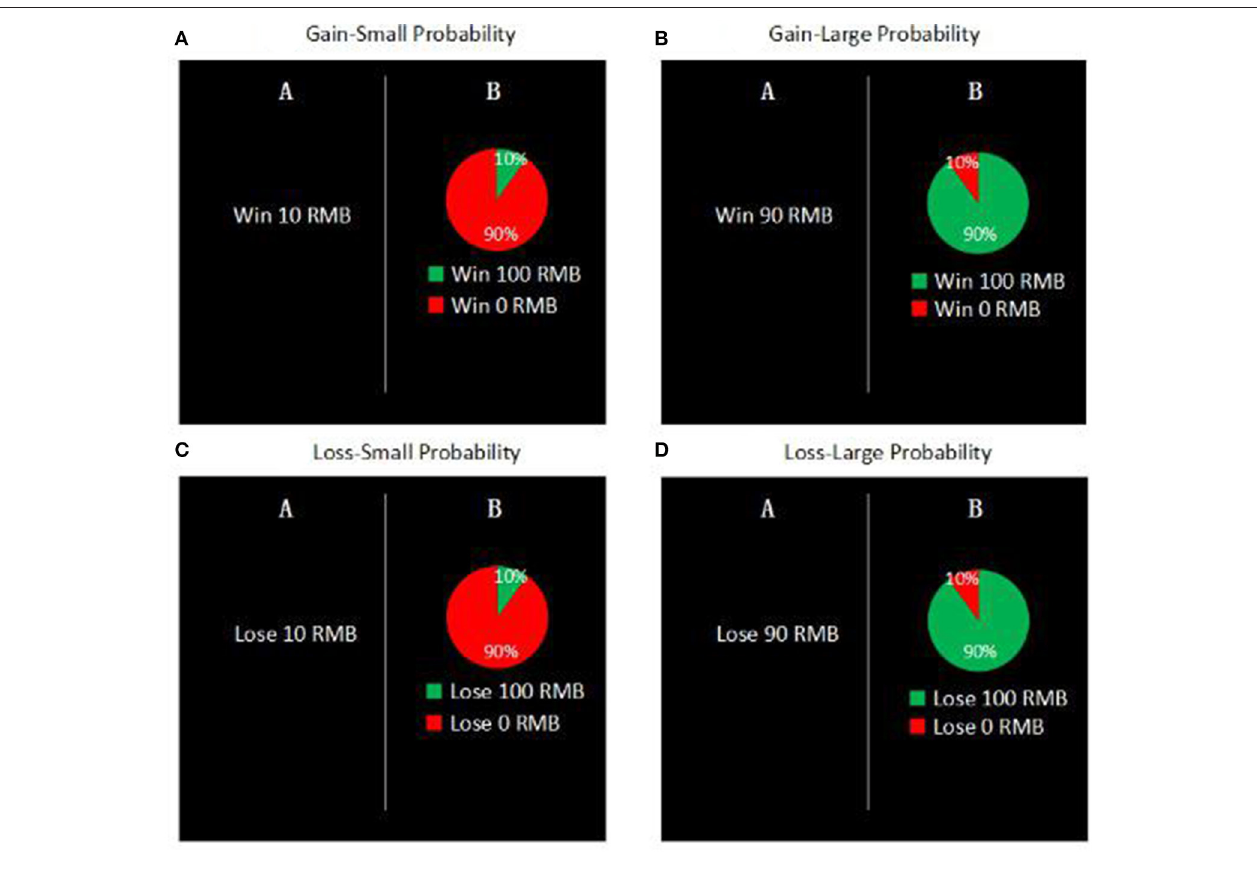
FIGURE 1 | Examples of the decision problems.